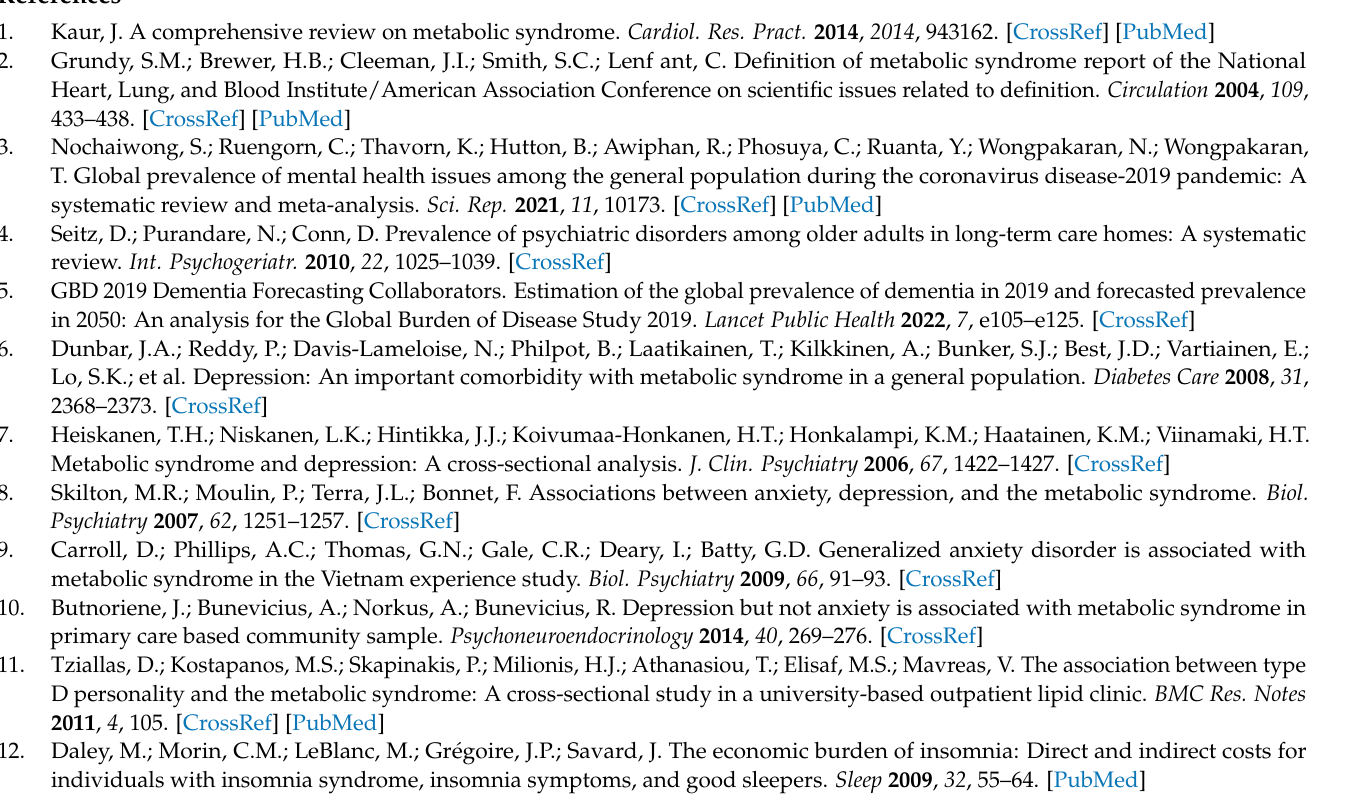
Table S1: The growth of Lactobacillus spp. Table S2: The growth of Bifidobacterium spp. Table S3: Body